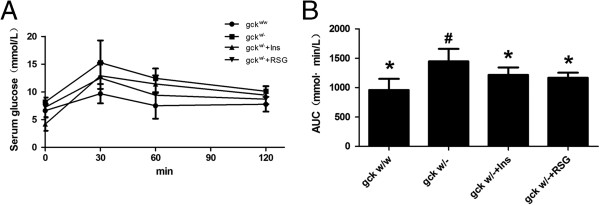
Intra-peritoneal glucose tolerance tests (ipGTT) in 60-week old liver-specific gck knockout mice. ipGTT (A) and areas under the curve of the ipGTT (AUC) (B) are shown. Glucose levels were measured at 0, 30, 60, 120 minutes after glucose injection in wild-type (gckw/w) and gck knockout (gckw/–) mice as well as knockout mice treated with insulin or rosiglitazone for 4 weeks. n = 6 for all samples. Asterisk (*) refers to statistical significance (P < 0.05) in comparisons with gckw/– mice, while # refers to comparisons with gckw/w mice.